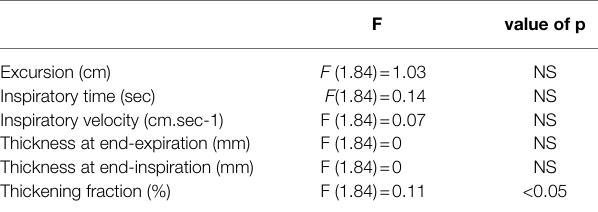
TABLE 3 | Study of the interaction effect (breathing volume: